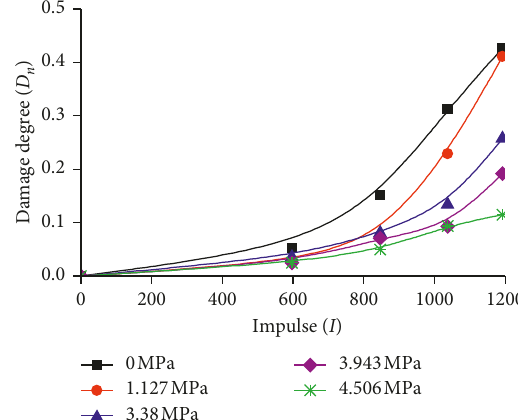
Figure 7: The relationship between damage degree and in- cremental impulse under different axial